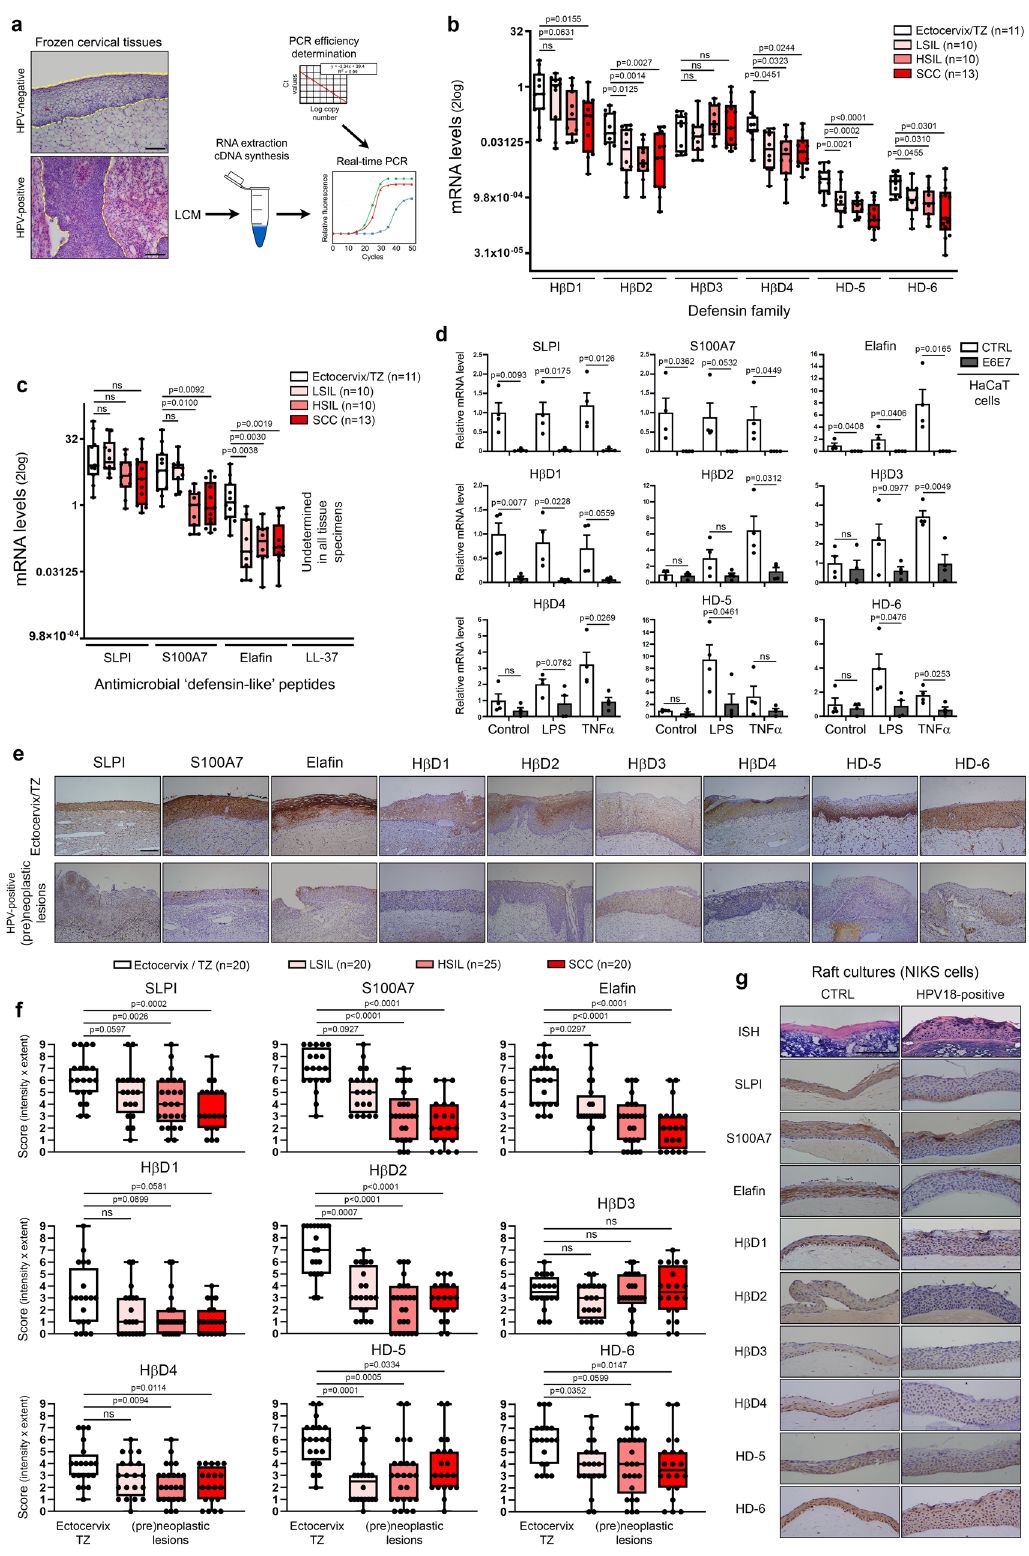
innate peptides (S100A7, ela fi n, H β D2, H β D4 and HD-5) (Sup- plementary Fig. 3). In order to determine whether or not HPV (and its viral oncoproteins) is directly responsible for the down- regulation of defensin(-like) peptides observed in (pre)neoplastic lesions, human keratinocytes were stably transduced with HPV16 E6E7 oncogenes and the expression level of each defense